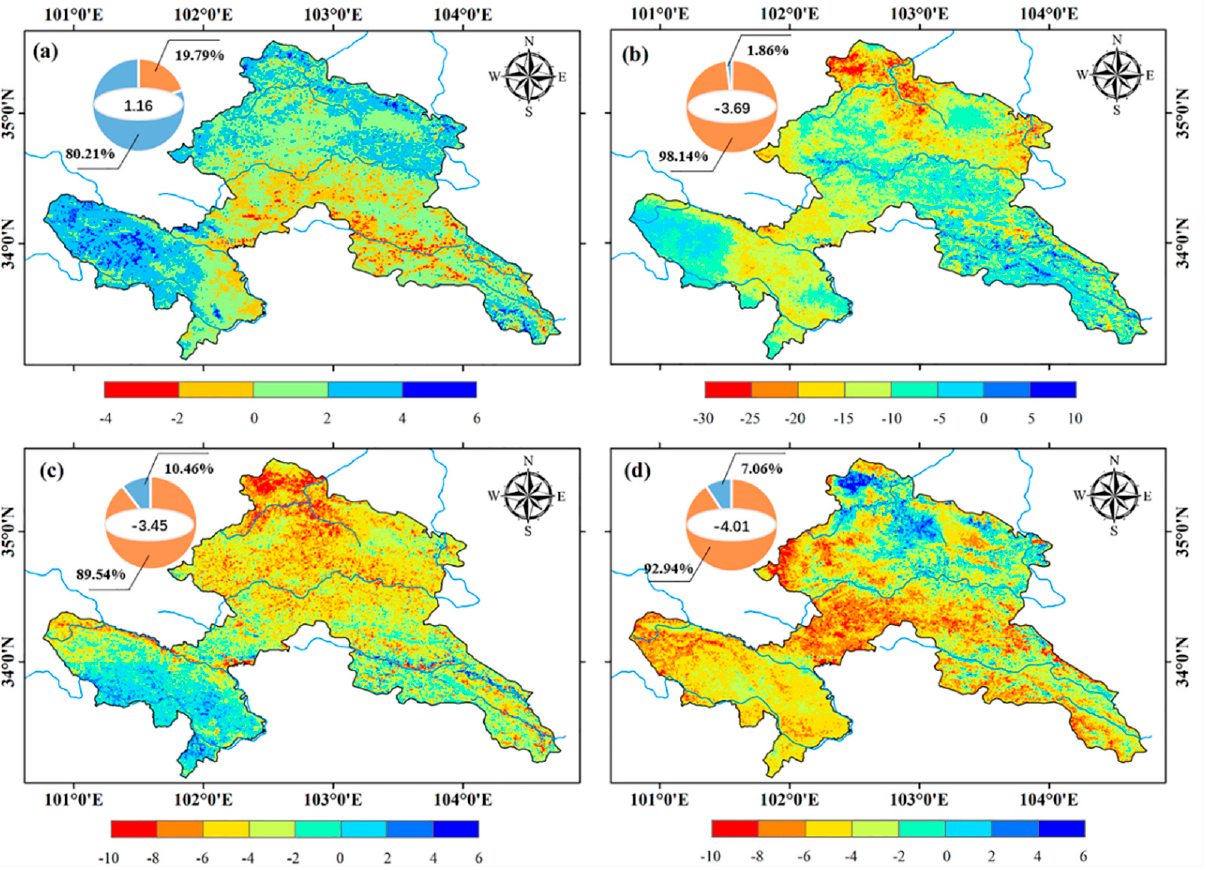
Figure 13. Spatial distribution of SCD sensitivity to the four climatic factors. Subplots ( a – d ) correspond to P, SSR, T max and T min , respectively. Fan diagrams in the upper left corners of subplots indicate the areal proportion of positively or negatively influenced and are differentiated using blue and orange, while the regional averages are indicated by the white part in the middle.